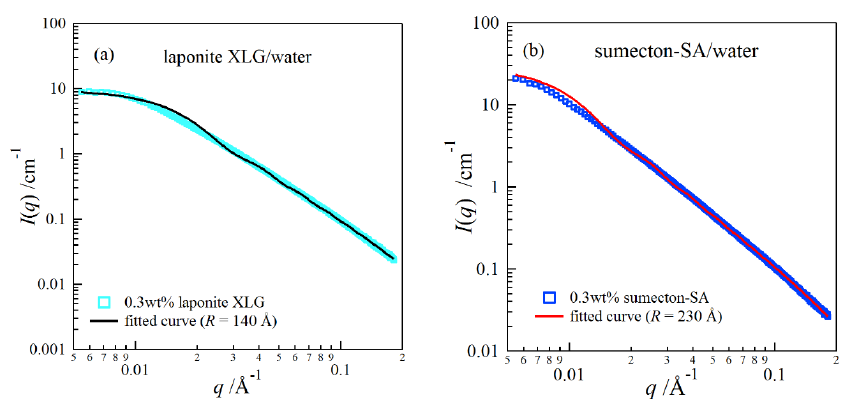
Figure 1. Small-angle X-ray scattering profiles for a 0.3 wt % laponite aqueous dispersion ( a ) and for a 0.3 wt % sumecton aqueous dispersion ( b ).